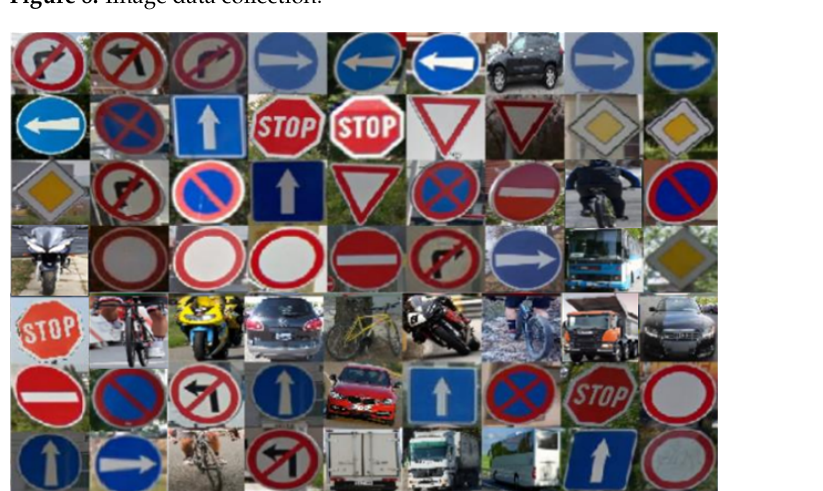
Figure 8. Image data collection.